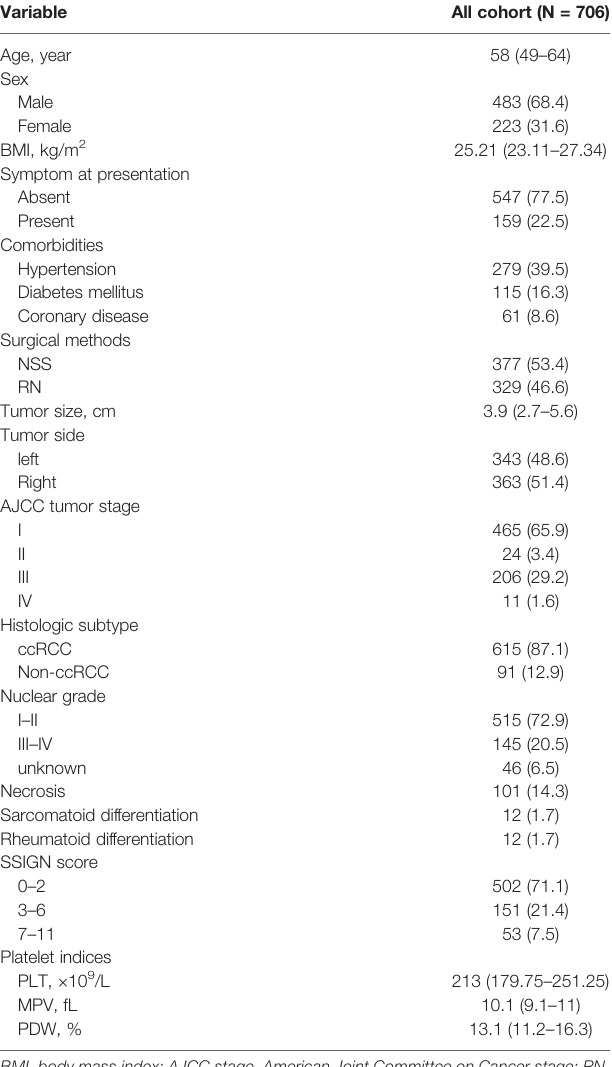
TABLE 1 | Descriptive characteristics of 706 patients treated with nephrectomy for nonmetastatic renal cell carcinoma.